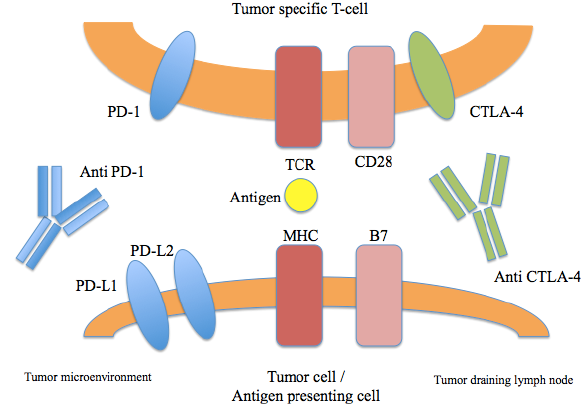
Figure 2. Immune checkpoints in melanoma therapy. Blockade of CTLA-4 or PD-1/PD-L1 results in the activation of T cells with specificity for cancer cells.